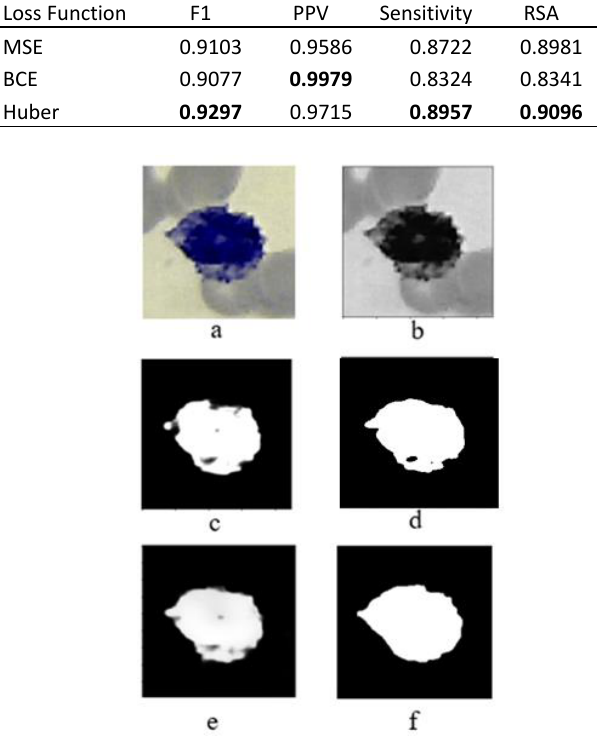
Fig. 7 Example of testing result (a) thin blood smear image, (b) grayscle image. (c) MSE, (d) BCE, (e) Huber, (f) ideal